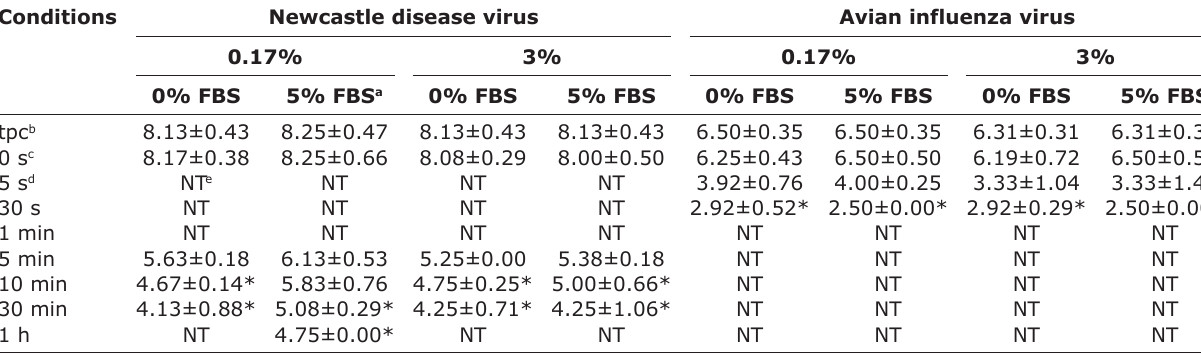
Table-3: The results are presented as log inactivating efficacy, using 0.17% and 3% of food additive grade calcium hydroxide solution, in the absence or presence of organic materials.